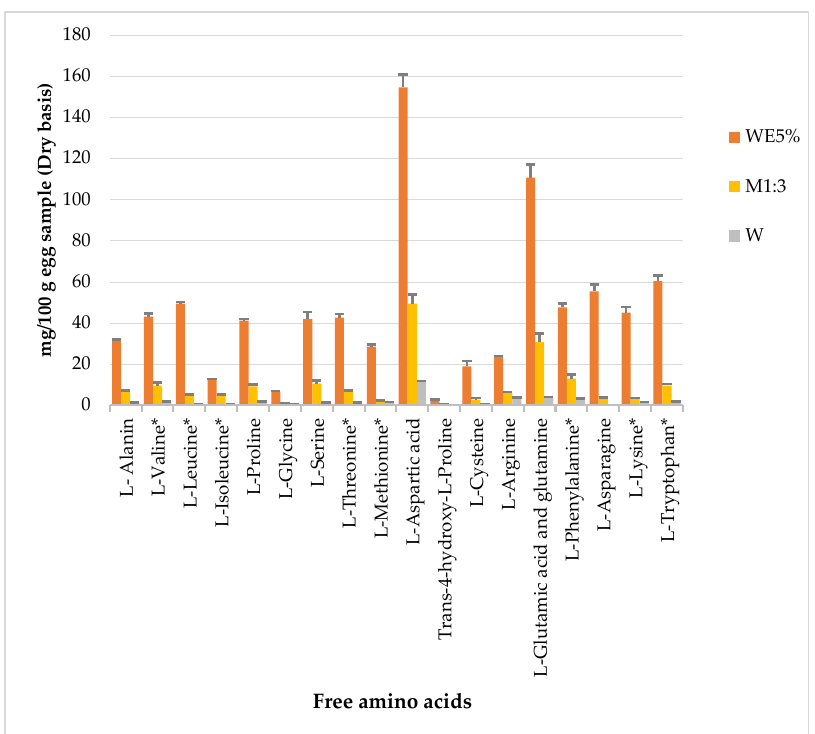
Figure 1. Free amino acid composition of egg powders: whole egg with the addition of 5% sucrose (WE5%); a mixture of 1 part egg yolk and 3 parts egg white (M1:3); and egg white (W). Average data ( n = 2). * Essential amino acids. Bars represent the standard deviation.